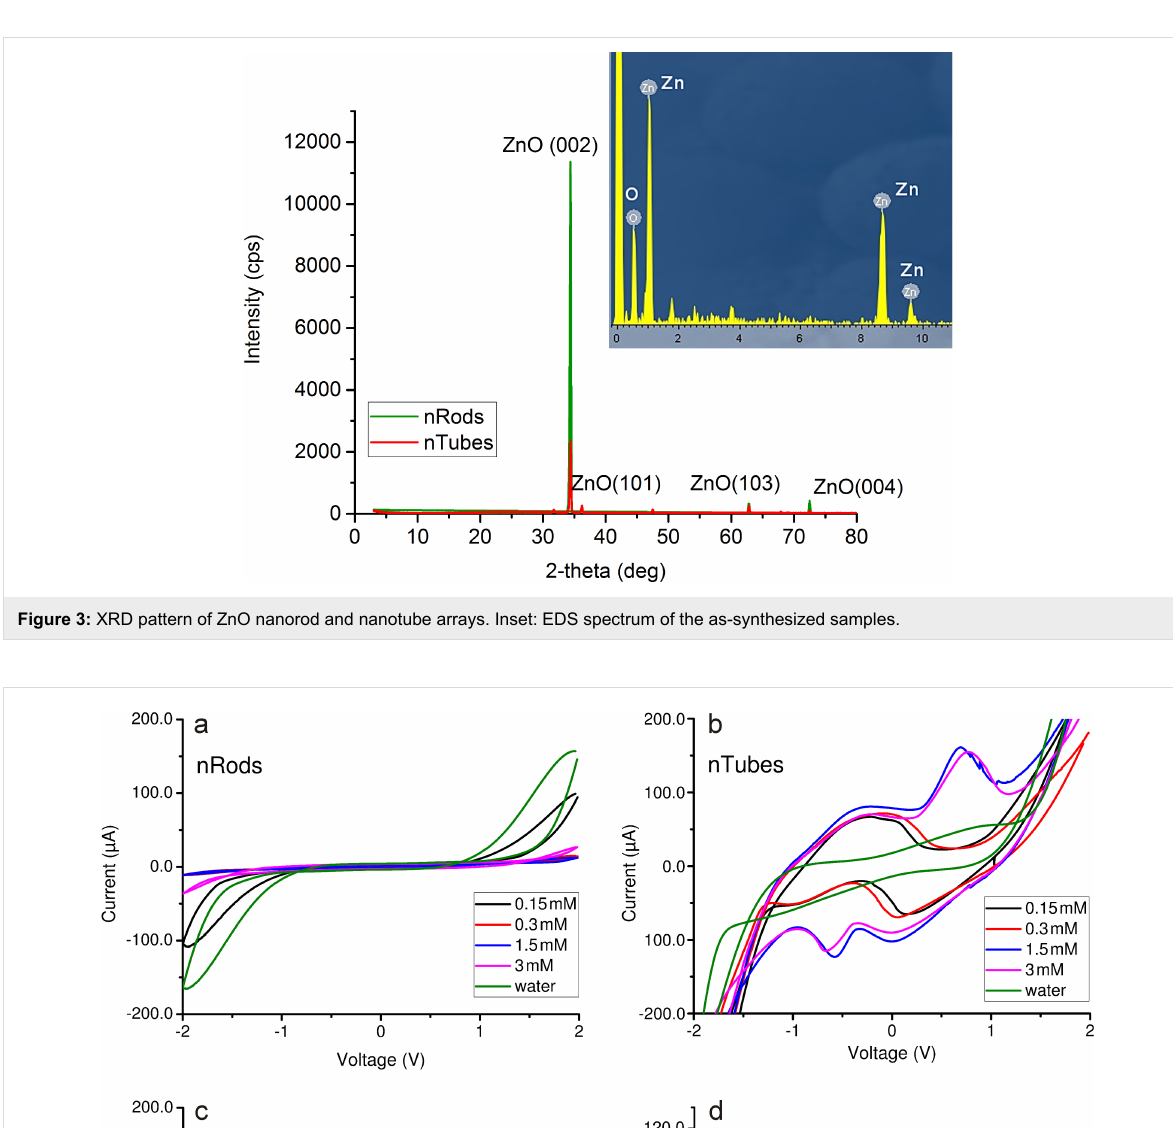
an asymmetry between the upper (oxidation) and the lower (reduction) components of the CV loop, which confirms that the process is irreversible: strong forces of attraction occur be-